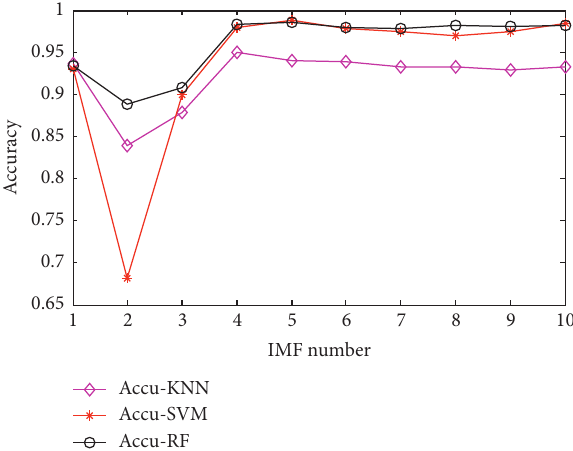
Figure 11: Diagnosis results of different classifiers under different IMF numbers.